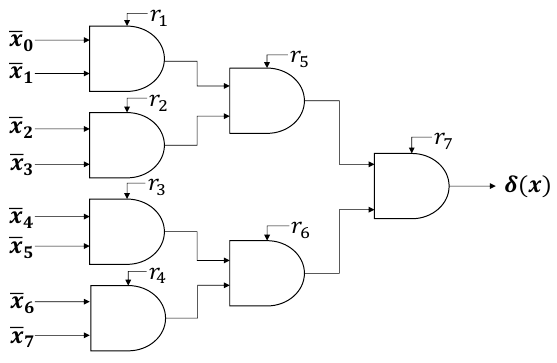
Figure 4: Circuit for the shared Kronecker delta function δ ( x ) for n =